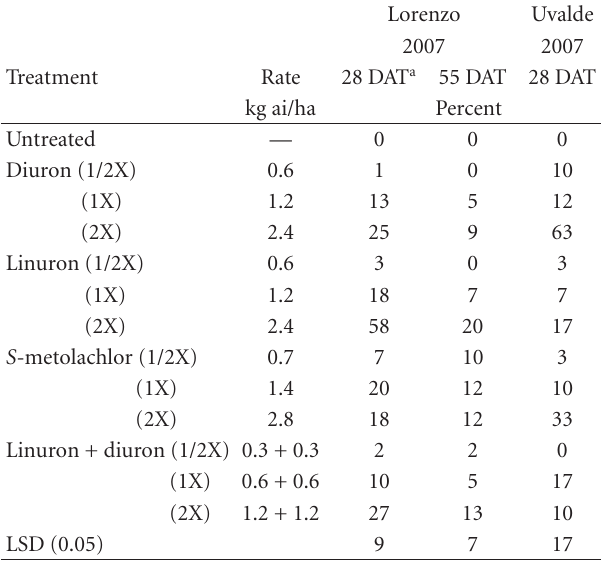
Table 3: Sesame stunting as influenced by preemergence herbicides at two locations in Texas.